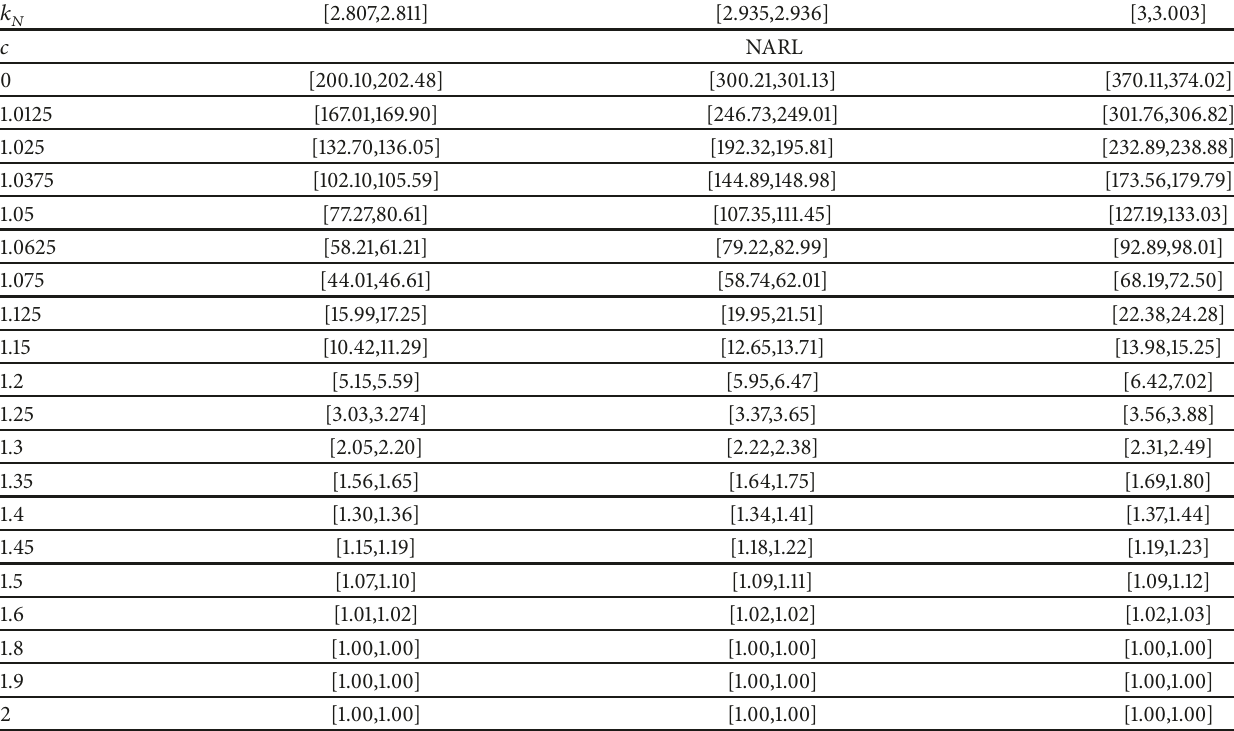
Table 3: The NARLs of proposed chart when V 𝑁 𝜖[0.36,0.37] and 𝑢 0𝑁 𝜖[2.85,2.90]